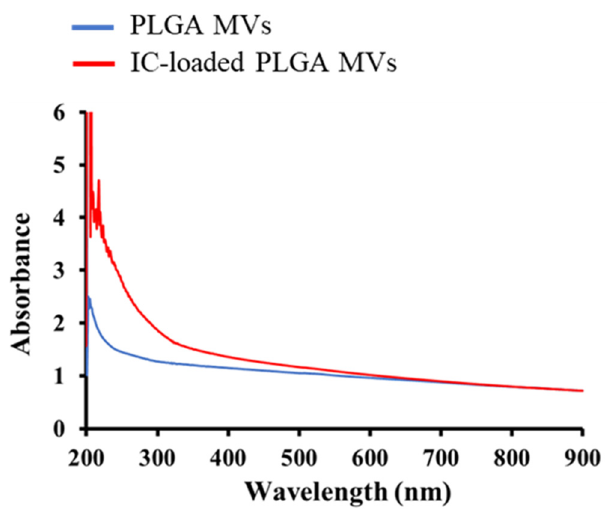
Figure 4. Optical characterization of PLGA MVs and IC ‐ loaded PLGA MVs.